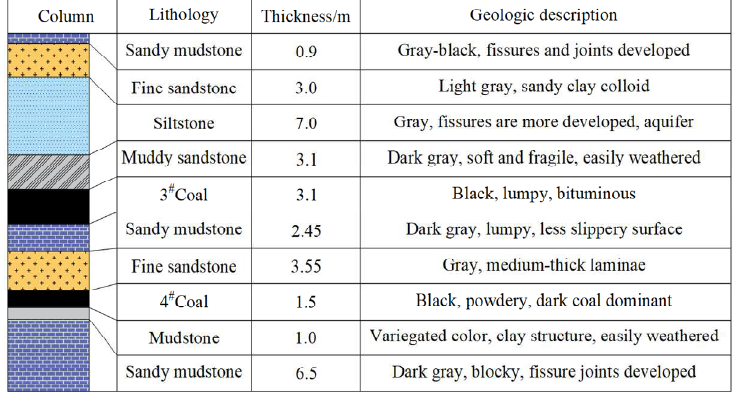
Figure 2. Description of coal and rock seams.